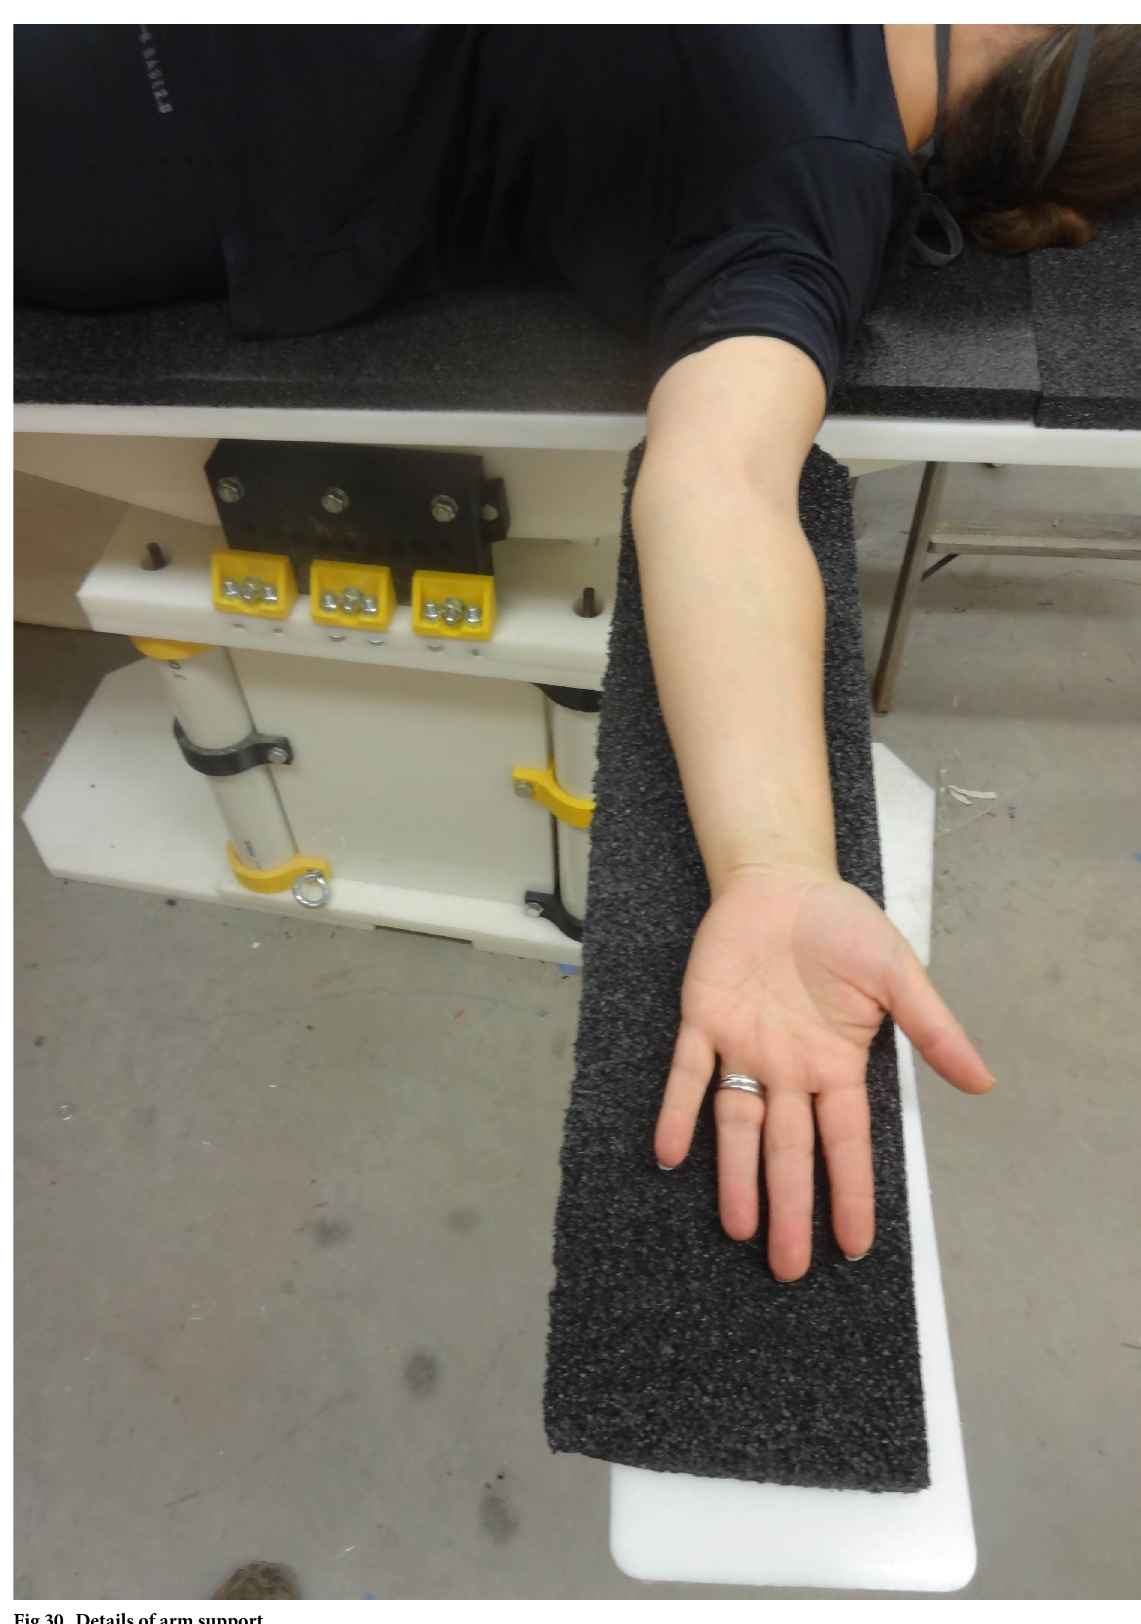
Fig 30. Details of arm